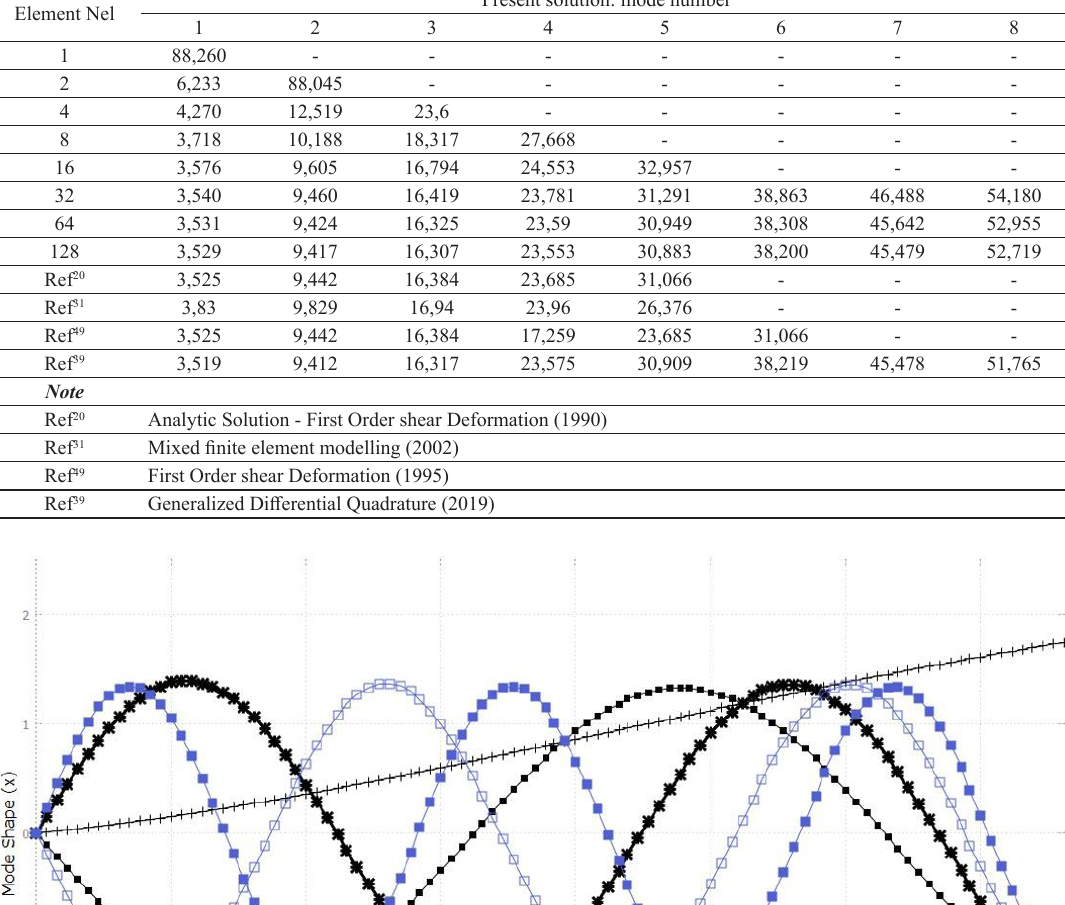
Table 10. Natural frequencies (nondimensional values) for CS beam - Laminated composite with (0/90/90/0) lamination scheme. Model containing parasitic shear. Element Nel